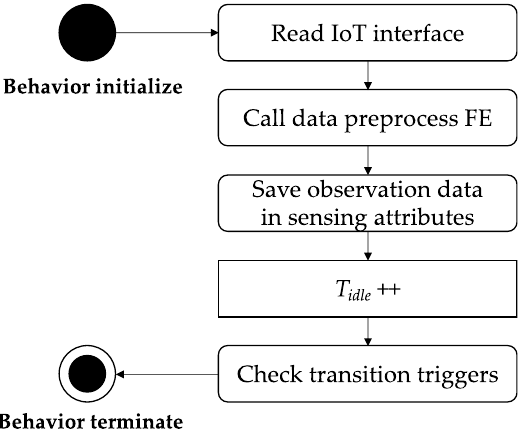
Figure 2. The sequence diagram for monitoring behavior.